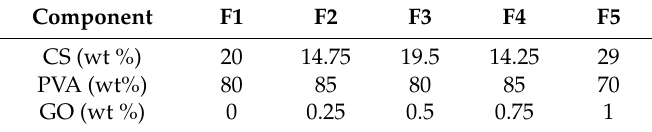
Table 1. Formulations (F1–5) used for the preparation of nanocomposite solutions.